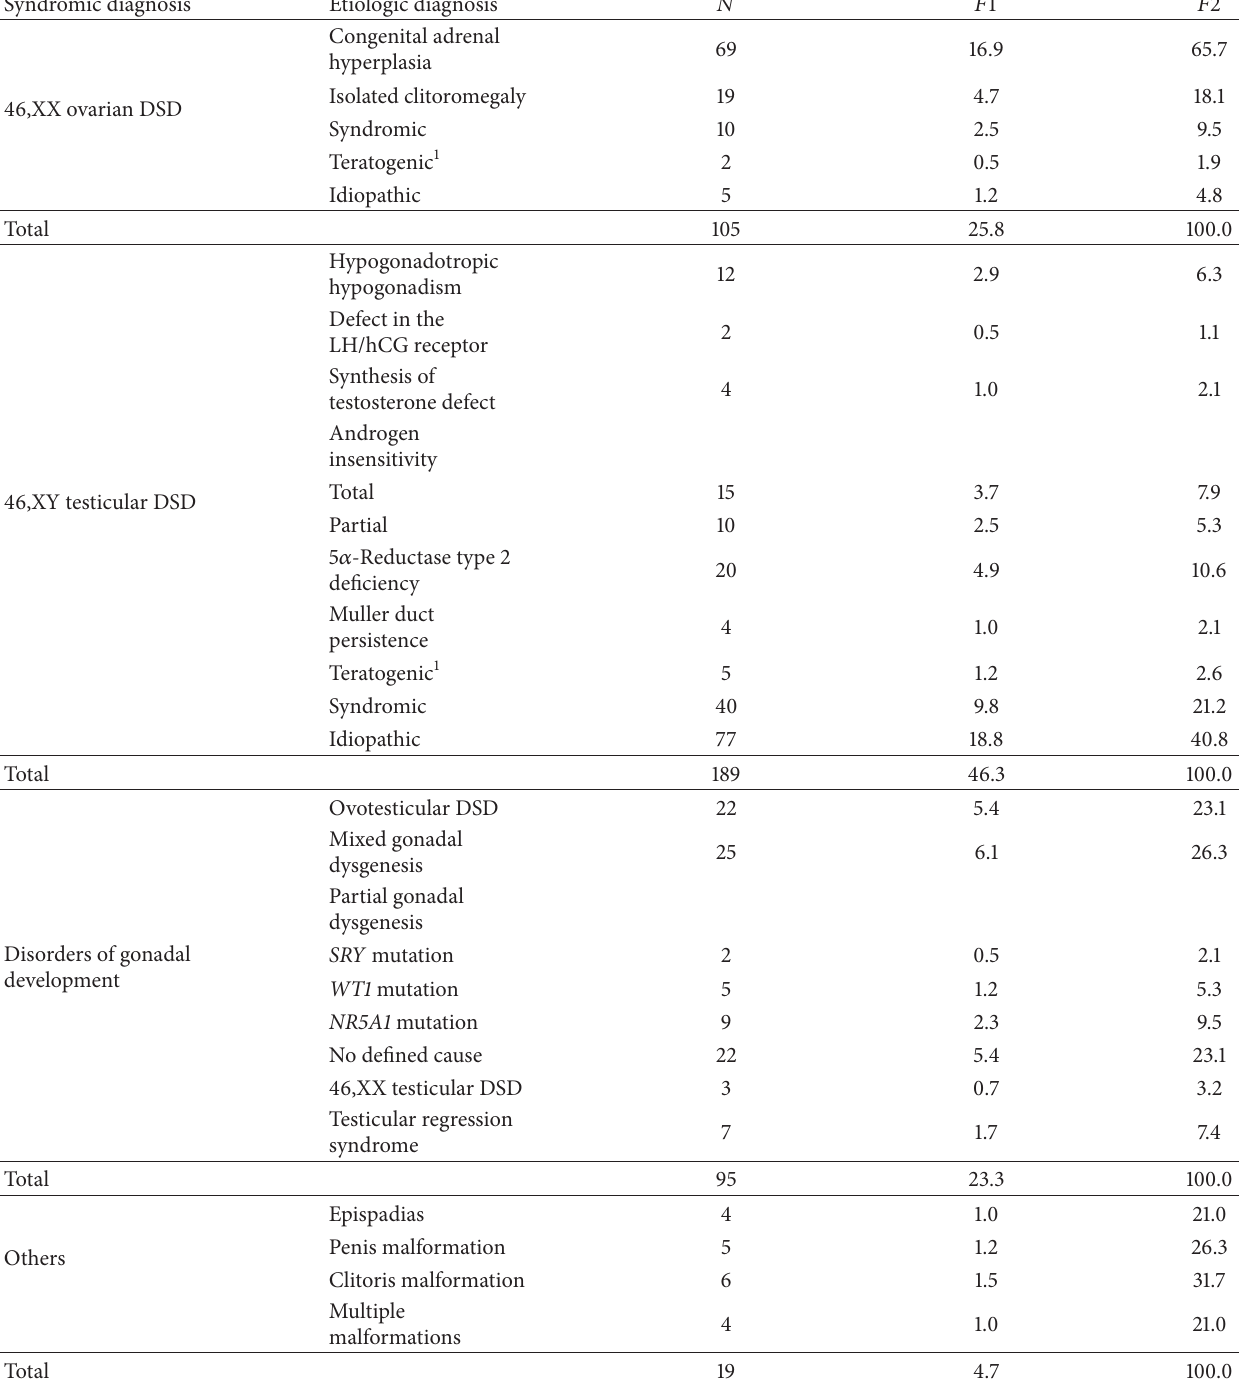
Table 1: Frequencies of etiological diagnosis in 408 consecutive cases of DSD with ambiguous genitalia followed at GIEDDS, UNICAMP, between January 1989 and December